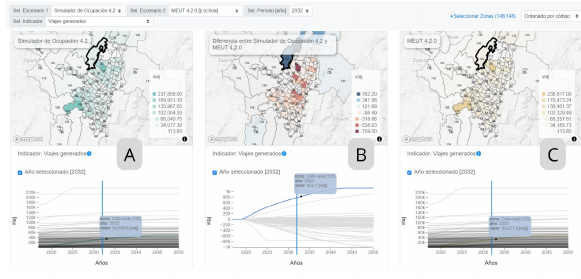
Figure 3. Intra-zone comparator explorer